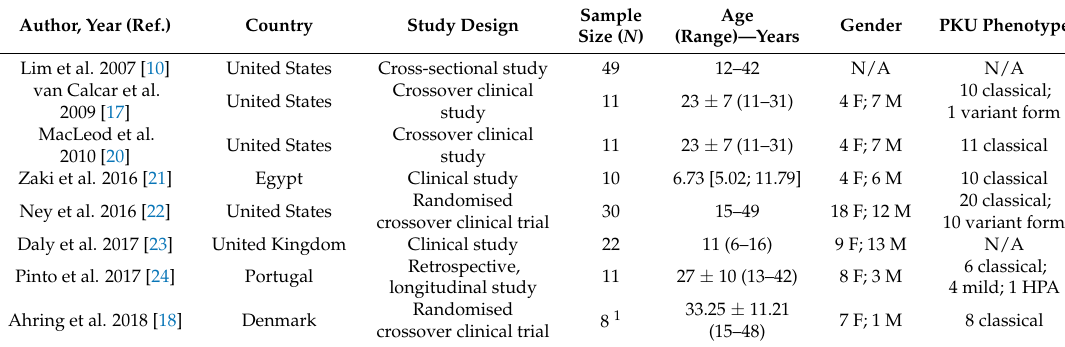
Table 1. Characteristics of studies included in the systematic review.